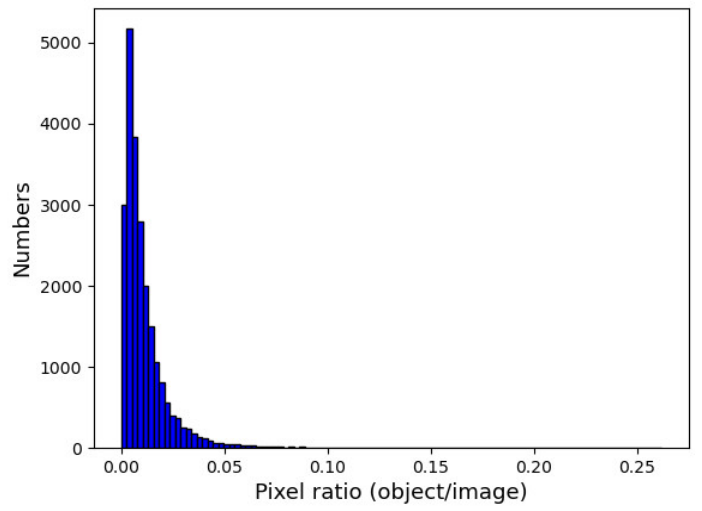
Figure 4. Target size distribution in marine organism dataset.